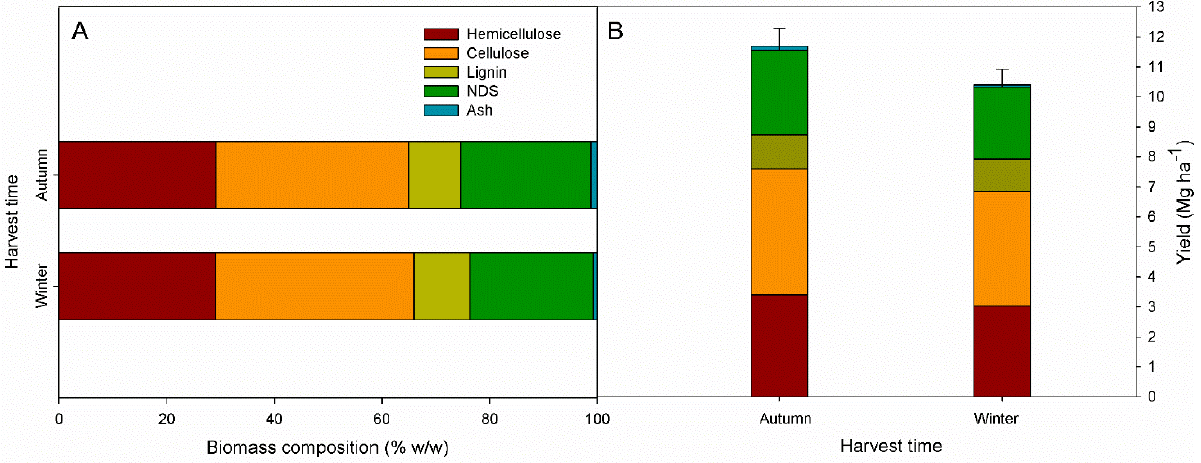
Figure 2. ( A ) Biomass composition (% w / w ) and ( B ) aboveground dry matter yield and yield components (Mg ha − 1 ) of giant reed ( Arundo donax ) at the autumn and winter harvest regimes. The aboveground dry matter yield (DMY) was higher in autumn than winter, 11.6 Mg ha − 1 and 10.4 Mg ha − 1 , respectively (Fugure 2B). The autumn harvest produced higher yield components: cellulose represented the largest part of giant reed yield, reaching 4.2 Mg ha − 1 in autumn and 3.8 Mg ha − 1 in winter harvest, followed by hemicellulose (3.4 and 3.0 Mg ha − 1 for autumn and winter, respectively), NDS (2.8 and 2.4 Mg ha − 1 for autumn and winter, respectively), ADL (1.1 and 1.0 Mg ha − 1 for autumn and winter, respectively),